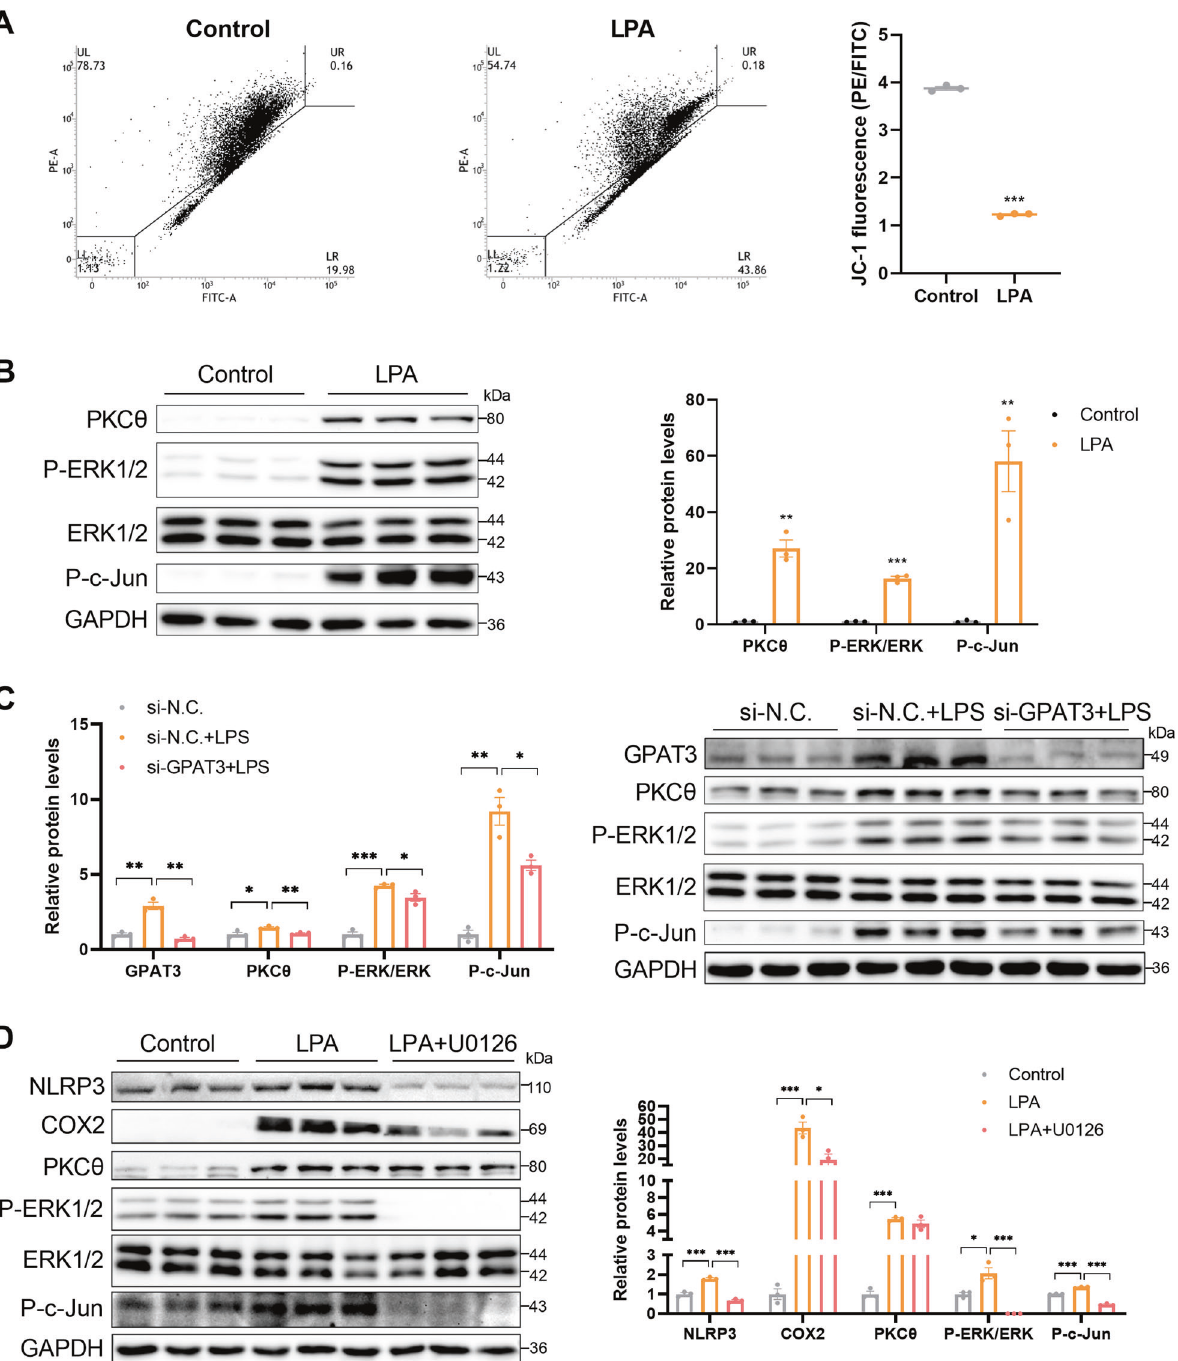
Fig. 6 GPAT3 promotes in fl ammation response through the LPA-mediated PKC θ , ERK1/2 and c-Jun pathway. A Mitochondrial membrane potential (JC-1) in KCs treated with 30 μ M LPA for 12 h ( n = 3). B Western blot images and quanti fi cation of PKC θ , P-ERK1/2 and P-c-Jun protein expression in KCs treated with LPA (30 μ M 12 h) ( n = 3). C Western blot images and quanti fi cation of GPAT3, PKC θ , P-ERK1/2 and P-c-Jun protein expression in LPS-stimulated KCs transfected with GPAT3 siRNA ( n = 3). D Western blot images and quanti fi cation of in fl ammatory cytokines and ERK1/2 pathway expression in control or LPA treatment KCs and pretreatment U0126 (10 μ M 2 h, ERK inhibitor) ( n = 3). Data represents mean ± SEM. * P < 0.05, ** P < 0.01, *** P <